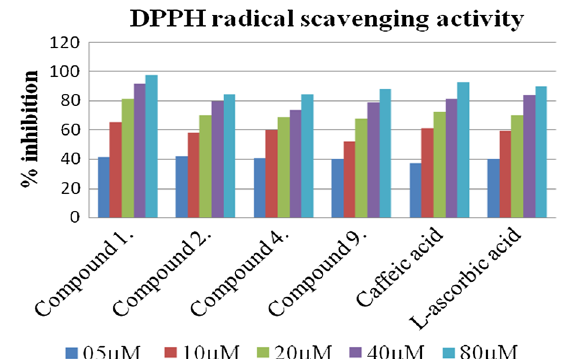
Fig. 6 DPPH radical scavenging activity of most active compounds with respect to reference l -ascorbic